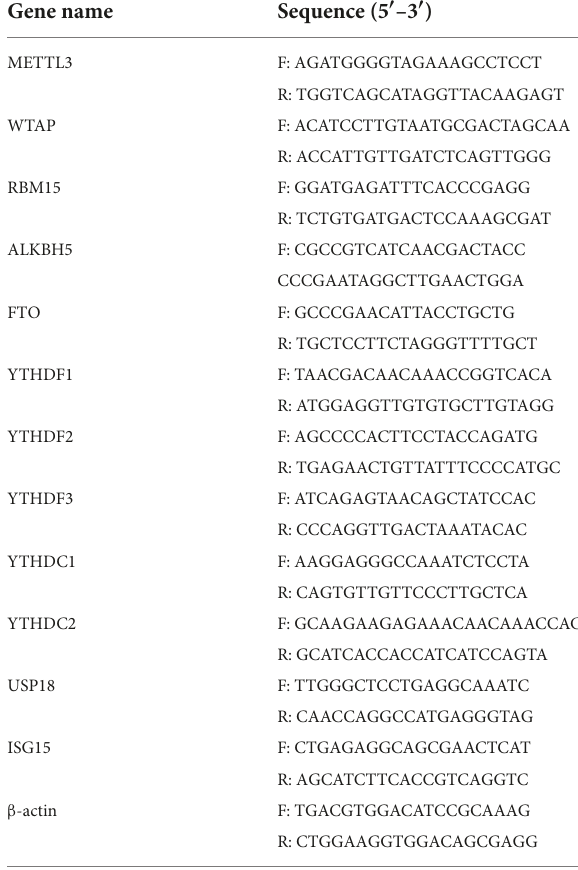
TABLE 2 The amplification primers sequences.